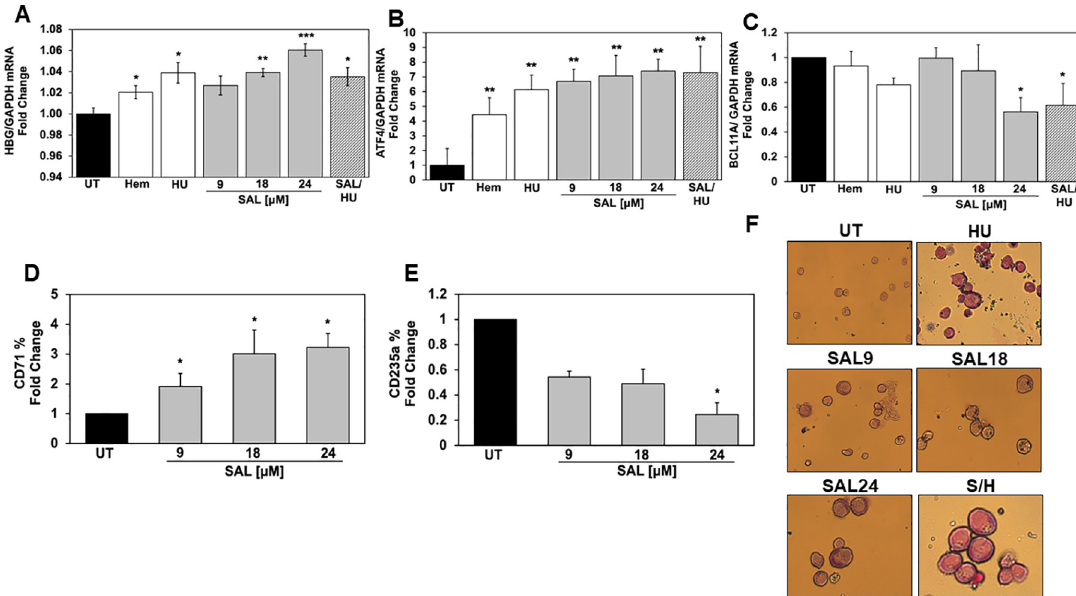
Fig 3. SAL activates HBG without changing HBB mRNA levels in sickle erythroid progenitors. Sickle erythroid progenitors were treated on day 8 with Hem 75 μ M, HU 75 μ M and SAL 9, 18 and 24 μ M alone or SAL 18 μ M combined with HU 75 μ M (SAL was dissolved in water). After 48 hours of treatment, data were generated and shown as the mean ± SEM (n = 6) and � p < 0.05; �� p < 0.01; ��� p < 0.001 was considered statistically significant. A) RT-qPCR demonstrated the HBG mRNA levels were normalized to GAPDH the internal control. RT-qPCR demonstrates B) ATF4 mRNA levels and C) BCL11A mRNA levels normalized with GAPDH . Sickle erythroid progenitors under the different treatment conditions were stained with human FITC-conjugated D) CD71 and E) CD235a antibody and analyzed by flow cytometry. F) Representative images of erythroid progenitors generated at 40-x magnification by light